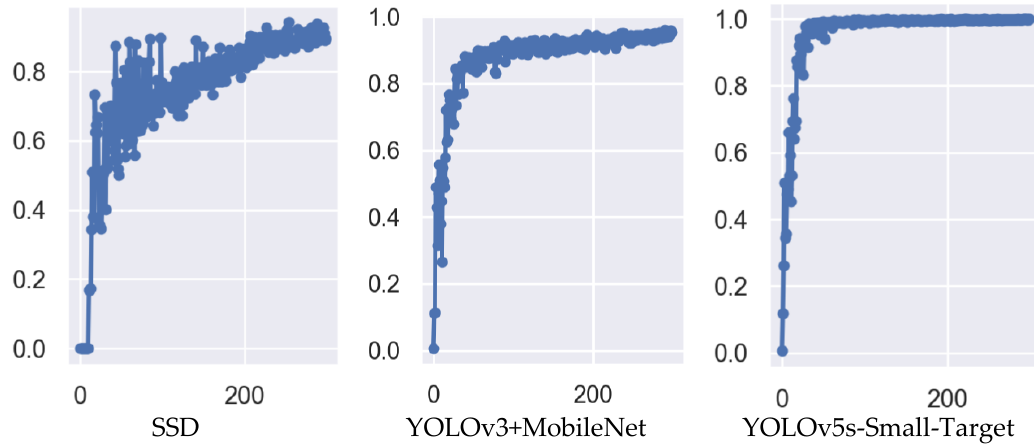
Figure 18. Comparison of defect detection loss values for different detection algorithms.